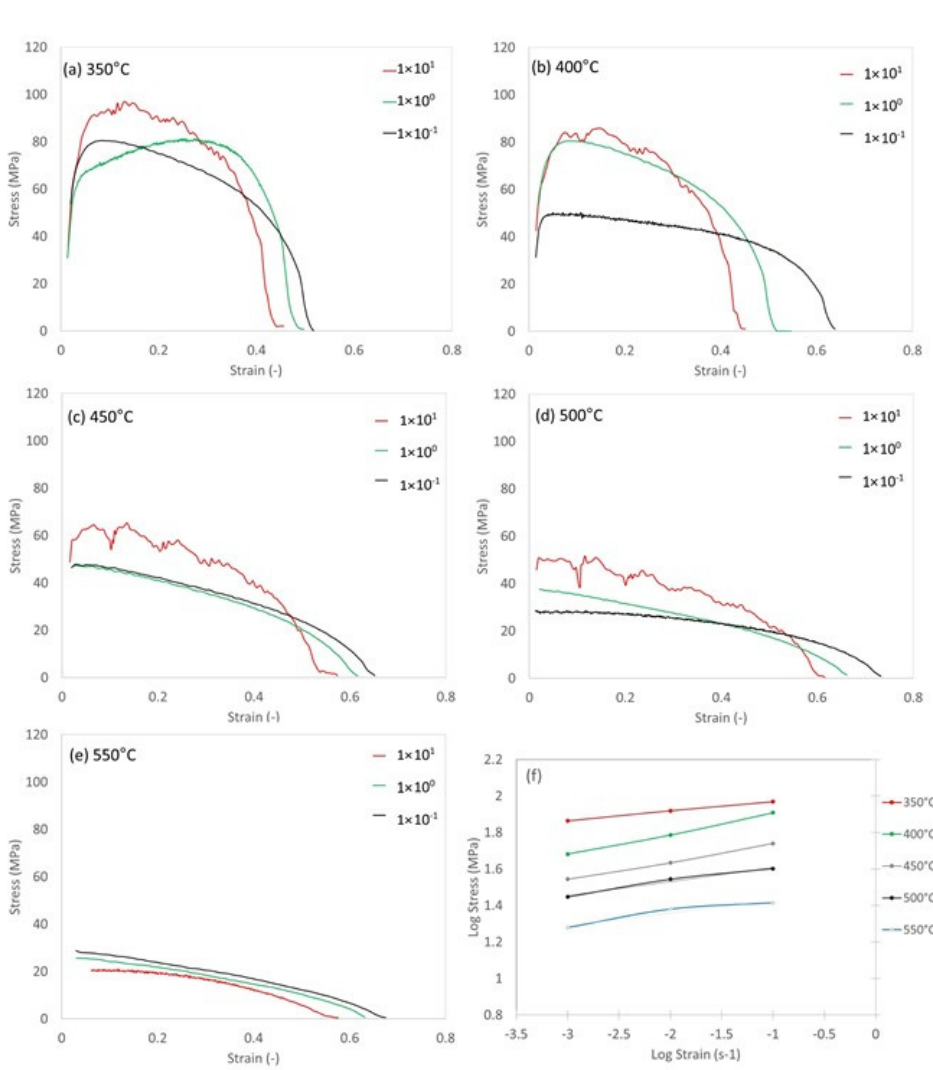
Figure 3. Stress vs. strain at ( a ) 350 °C, ( b ) 400 °C, ( c ) 450 °C, ( d ) 500 °C, and ( e ) 550 °C, ( f ) ‘m’ values of material across all temperatures at 0.1 strain.